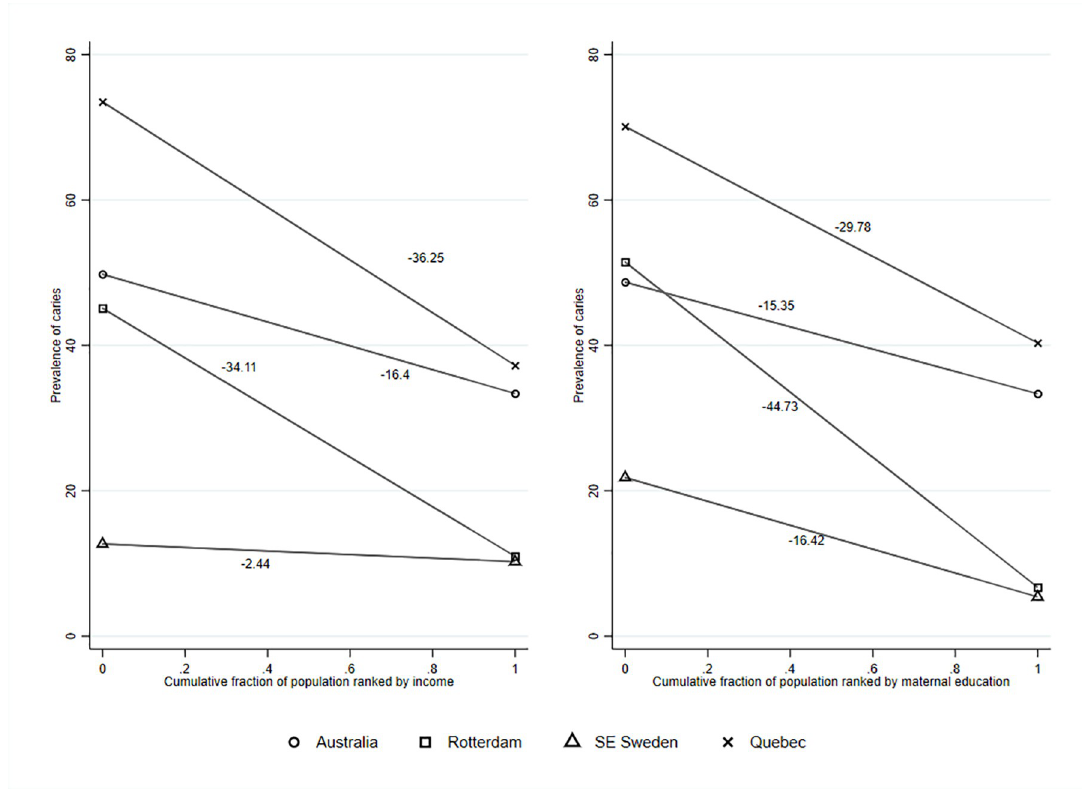
Fig 2. Slope Index of Inequality (SII) in child dental caries by income and